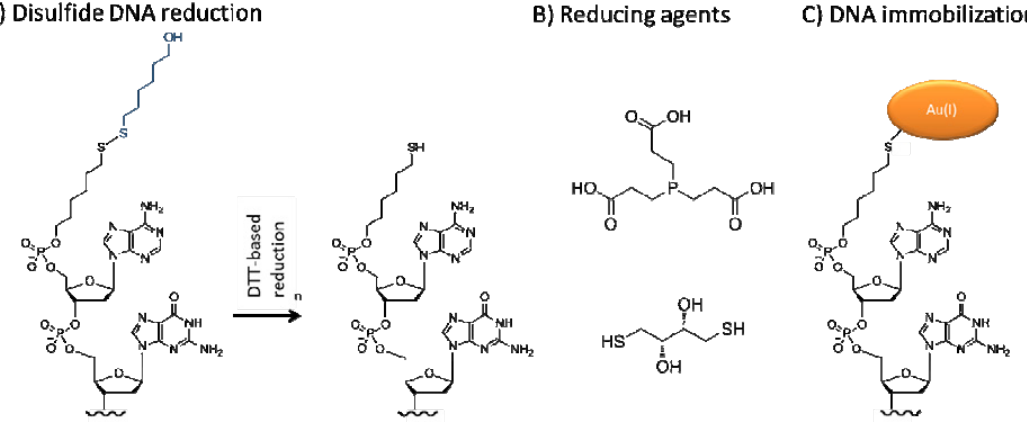
Fig. 2. Reduction of thioated DNA and its immobilization on the gold surfaces. A) Thiolated DNAs are shipped in disulfide oxidized form and are subject to reduction prior to application. B) The reducing agents are usually TCEP (above) or DTT (bottom). C) The reduced thiolated DNAs may form a covalent Au-S bond to the surface of gold nanoparticles or gold